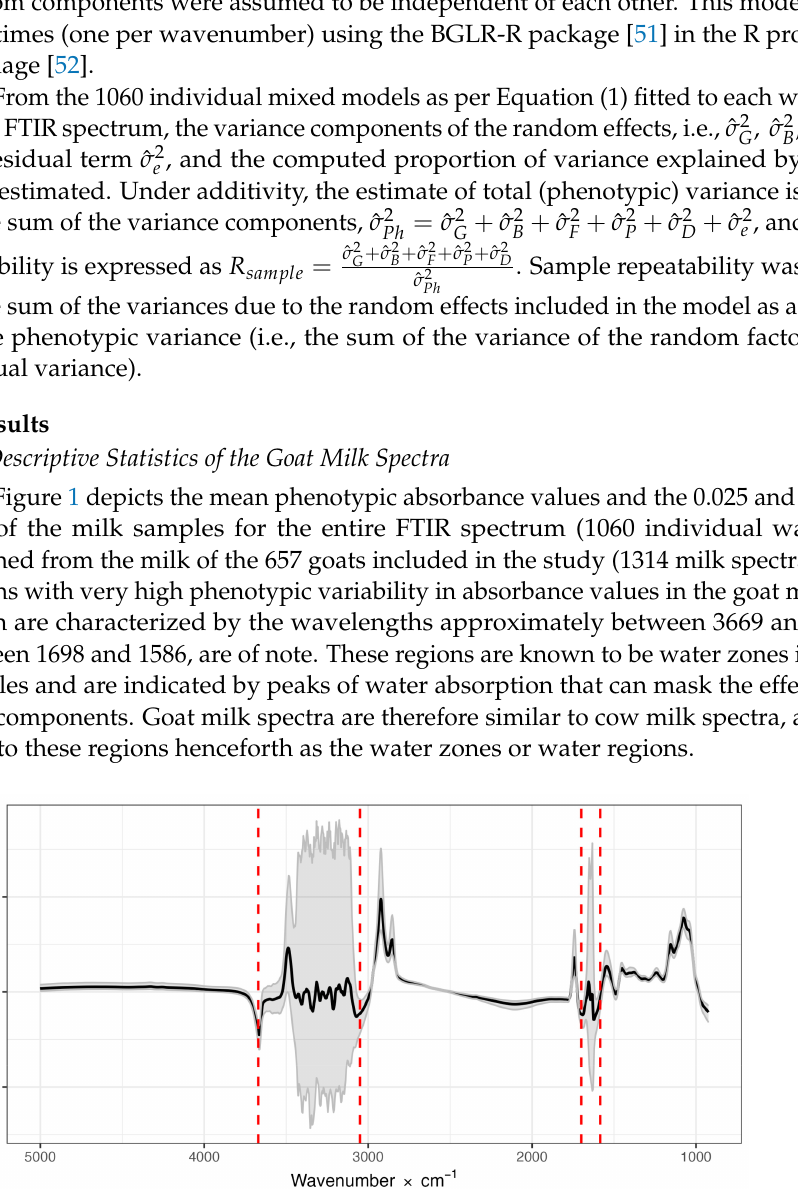
Figure 1. Mean absorbance values (dark solid line) and the 0.025 and 0.975 quantiles (gray lines) of the 1060 individual infrared wavelengths (5000 to 930 × cm − 1 ), measured from 1314 spectra of milk samples from 657 goats. Red dashed lines indicate regions with high